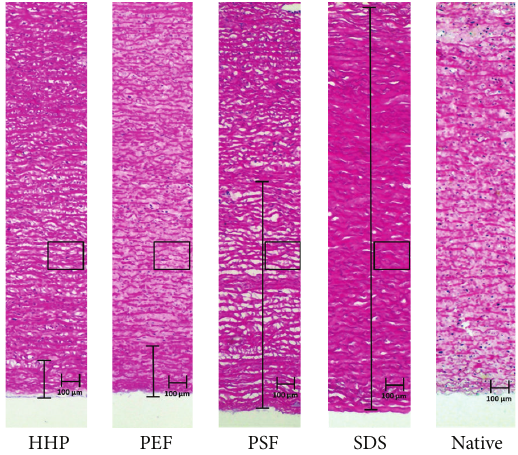
Figure 2: Illustration of the penetration depth (absence of cell nuclei) of the different treatment techniques compared to native tissue. In the rectangles, the areas that are shown in Figures ?? and 4 are